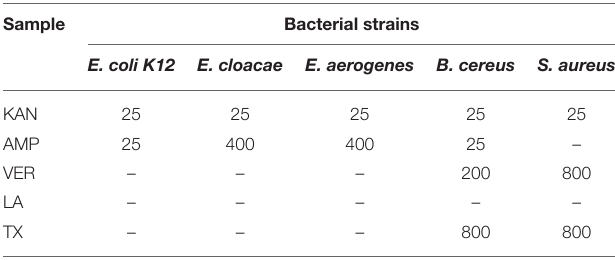
TABLE 2 | Minimum inhibitory concentration of antibiotics and SCB extracts against bacteria strains ( µ g/mL). Sample